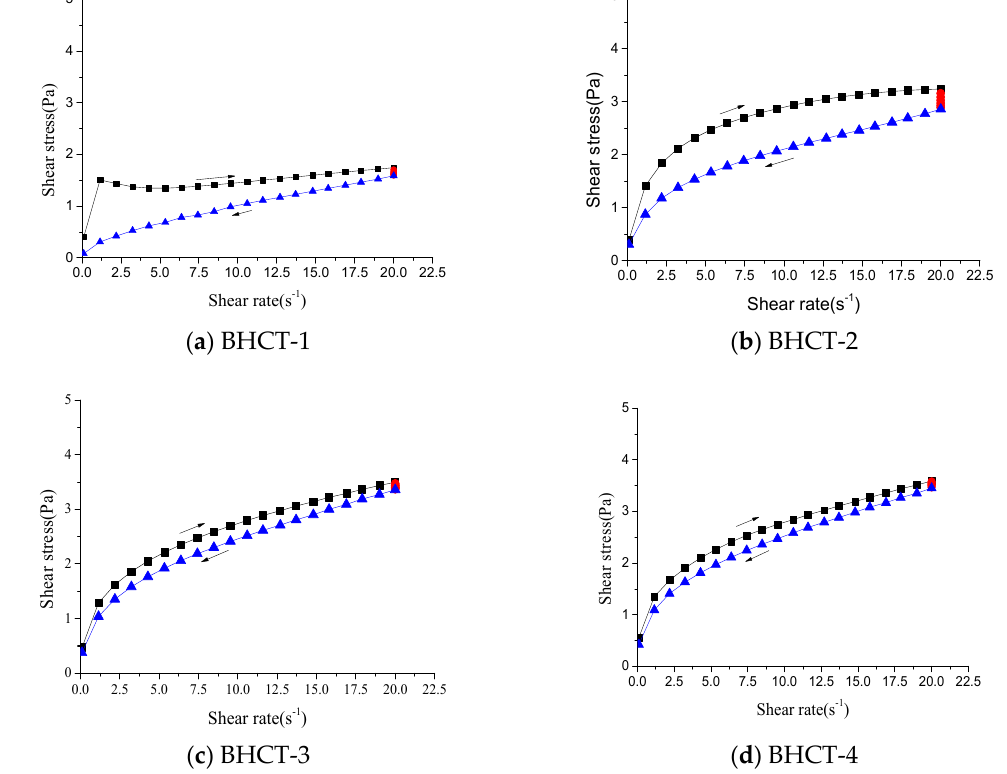
Figure 9. Shear thixotropy of composite gels at different bentonite concentrations. Table 3. Thixotropic ring area of composite gels of different bentonite concentrations.